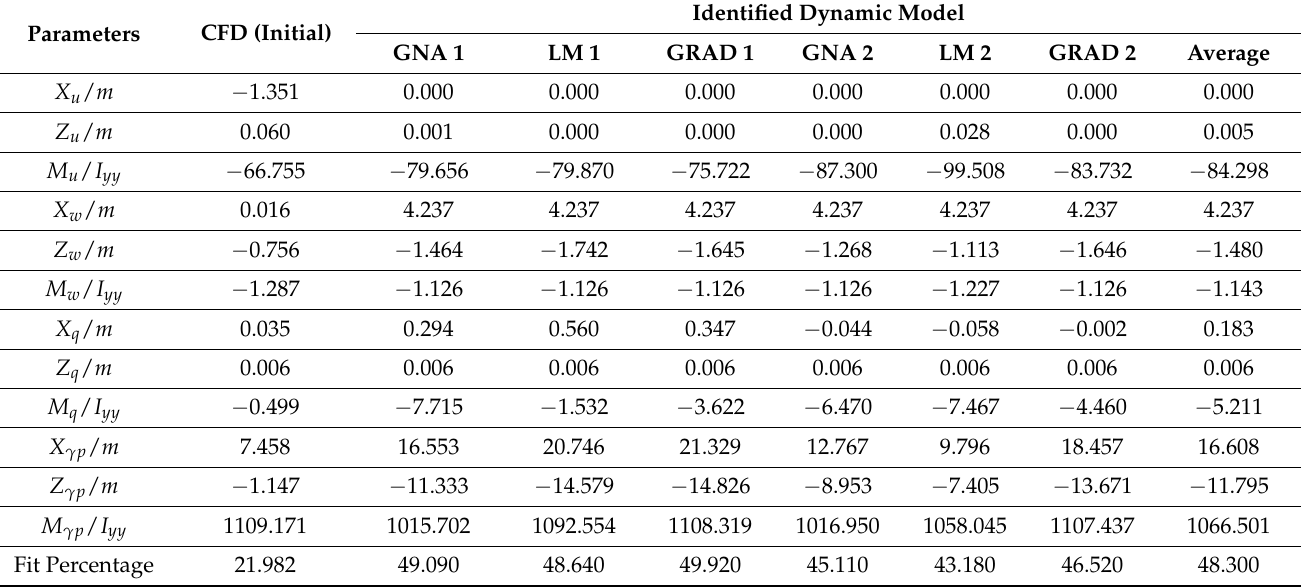
Table 3. Refined parameters of identified dynamic models using an indirect